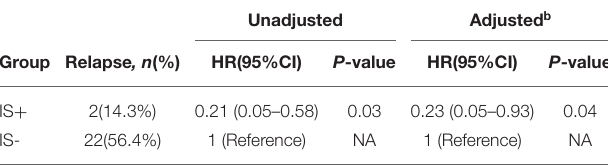
TABLE 3 | Cox regression a : analysis for IS therapy and MG relapses.